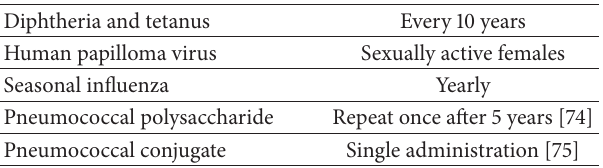
Table 4: Vaccine recommendations in adult Portuguese patients with systemic lupus